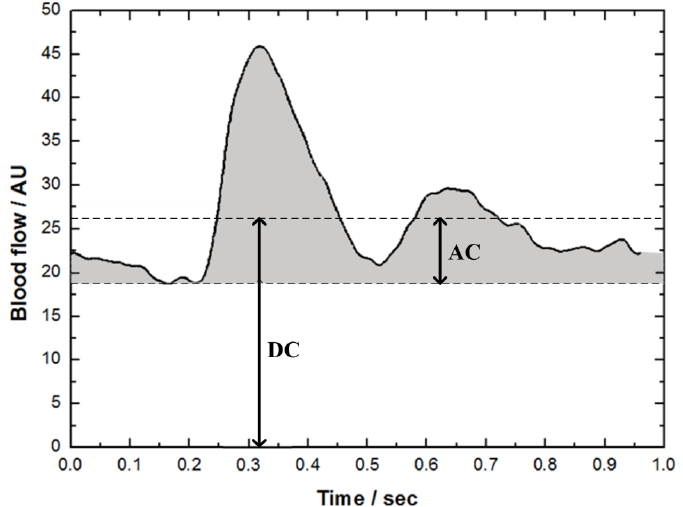
Figure 4. The definitions of DC and AC components of mean LDF waveform derived from segments of LDF